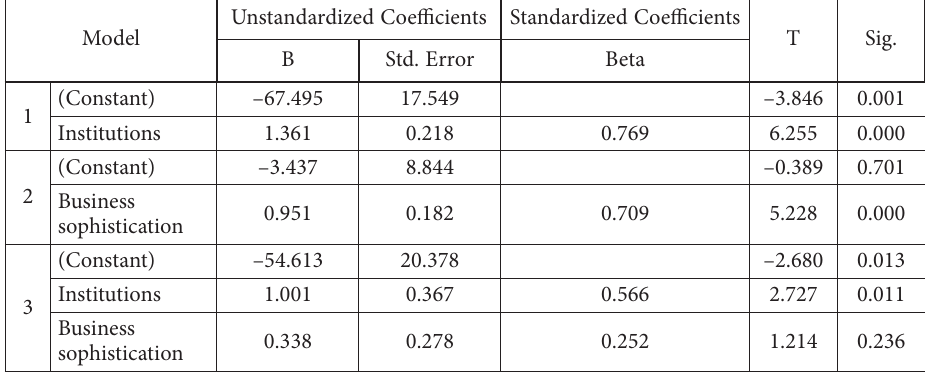
Table 2. Regression coefficients